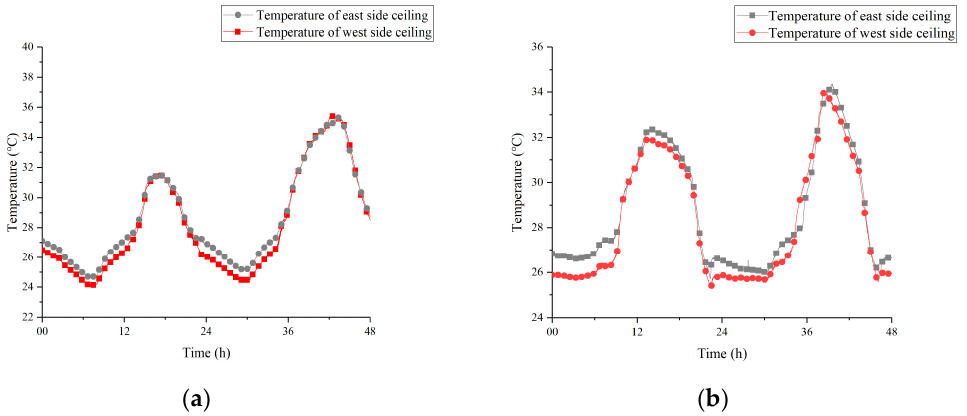
Figure 13. Horizontal contrast of ceiling temperature under two strategies ( a ) 12 h; ( b ) 8 h.